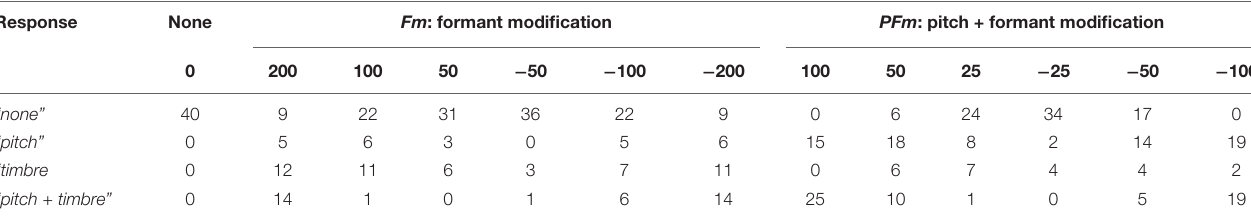
TABLE 1 | Subjective responses in the post-experiment subjective